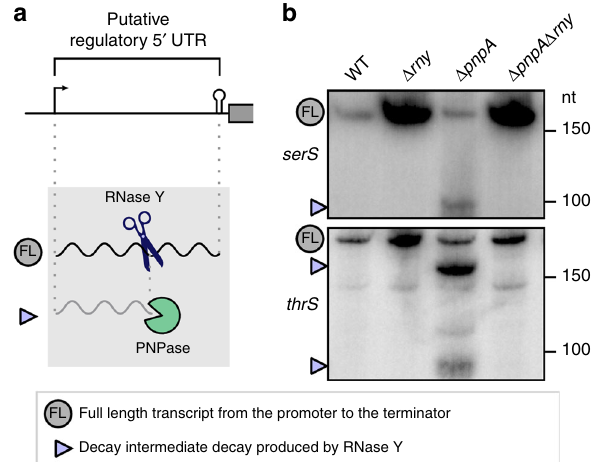
Fig. 8 RNase Y initiates the exoRNase-mediated degradation of putative regulatory 5 ′ UTRs. a Left, models of decay of putative regulatory elements. RNase Y (blue scissors) processes regulatory 5 ′ UTR elements, producing decay intermediates that are subsequently degraded by PNPase ( ‘ pacman ’ symbol) (see also Supplementary Fig. 7). b Northern blot analyses of putative T-boxes ( serS and thrS ) in the WT, Δ rny , Δ pnpA and Δ pnpA Δ rny strains. The full-length (FL) and RNase Y-generated decay intermediates (purple arrowheads) are indicated. Shown are the results of one representative northern blot analysis ( n = 3). The full blots, the loading controls, the RNA end pro fi le with the detected 5 ′ and/or 3 ′ rny _ends obtained by RNA sequencing, and the trimming start and stop positions are shown in Supplementary Fig. 7 and the source data are provided as a Source Data fi